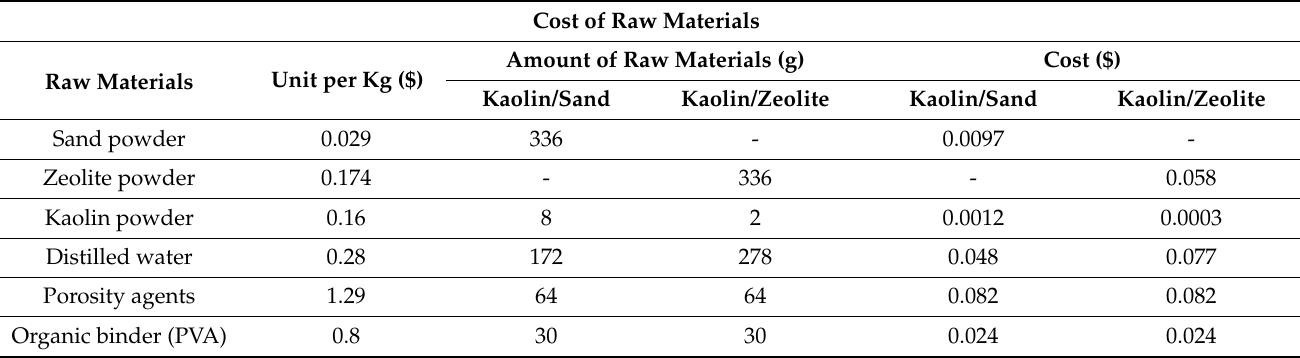
Table 4. Details of cost estimation for fabrication of Kaolin/Sand and Kaolin/Zeolite membranes. Cost of Raw Materials